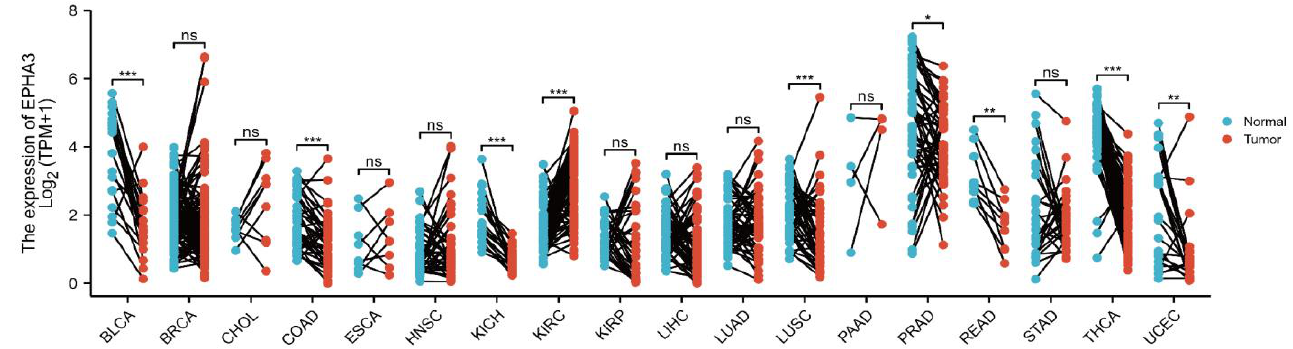
Figure 2. The EPHA3 expression levels in pan-cancers including paired samples in the TCGA database. * p < 0.05, ** p < 0.01, *** p < 0.001, ns stands for no statistical difference.